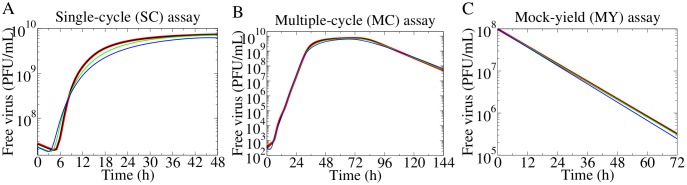
Simultaneous fits of the release MM to the simulated SC, MC, MY titers with a constraint on virus production.As in Fig 3, but with a constraint on the virus production rate, i.e., prelease = psimple(r + c)/r where psimple = 6.28 × 108(PFU/mL) ⋅ h−1.